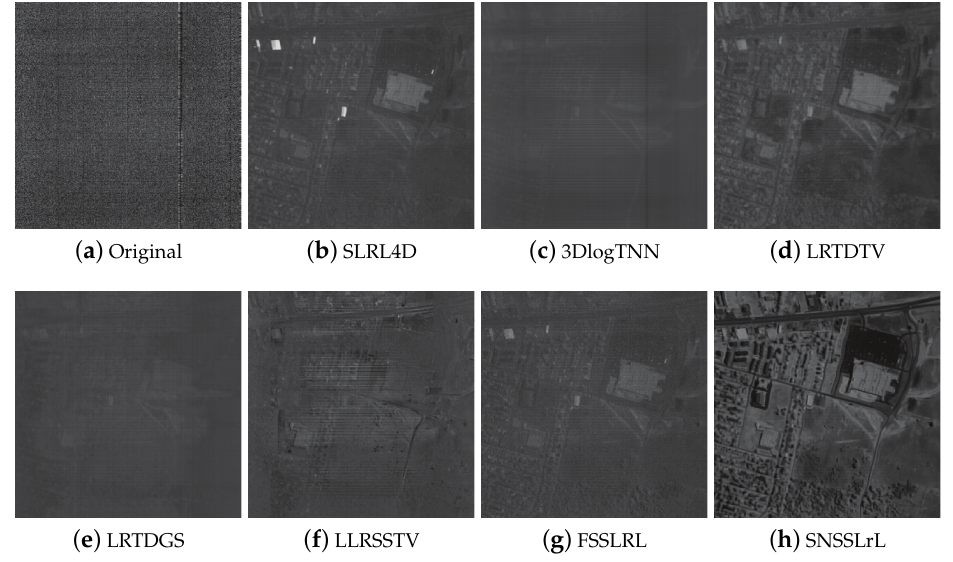
Figure 11. Real comparison of all methods on bands 210 of Urban